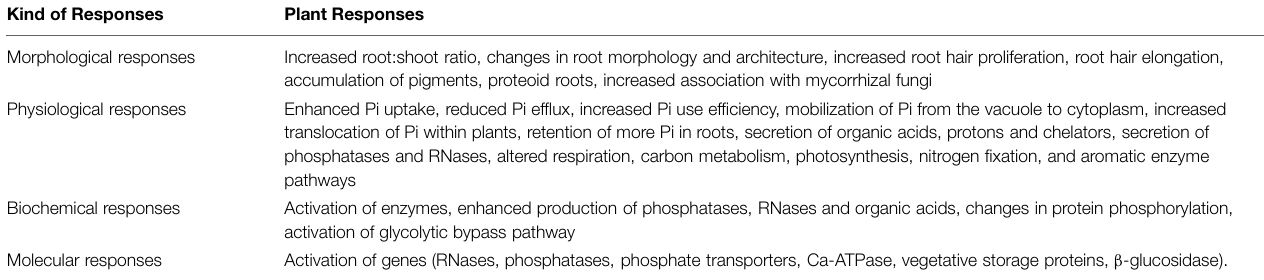
TABLE 1 | Multiple responses of plants under Pi deficient conditions (Raghothama,